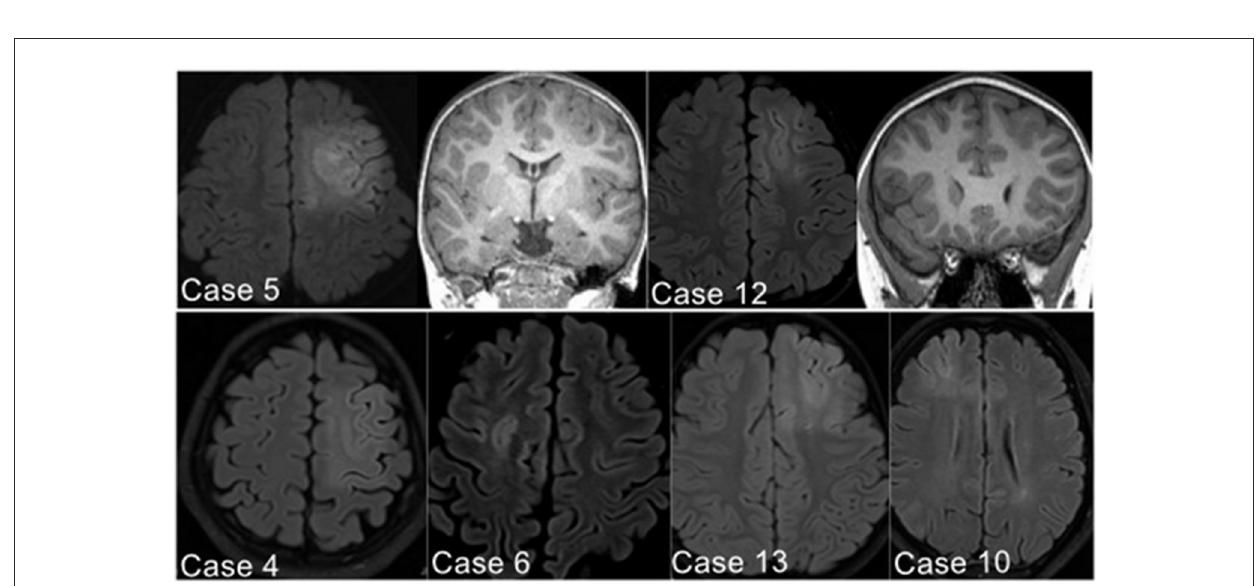
FIGURE2 Illustrative MRI positive examples. Six patients in the PS group demonstrated the suspected FCD in the SFS, detected with axial image of Flair sequence (Case 10 located in the anterior part of left SFS; the other five cases found in the posterior part of